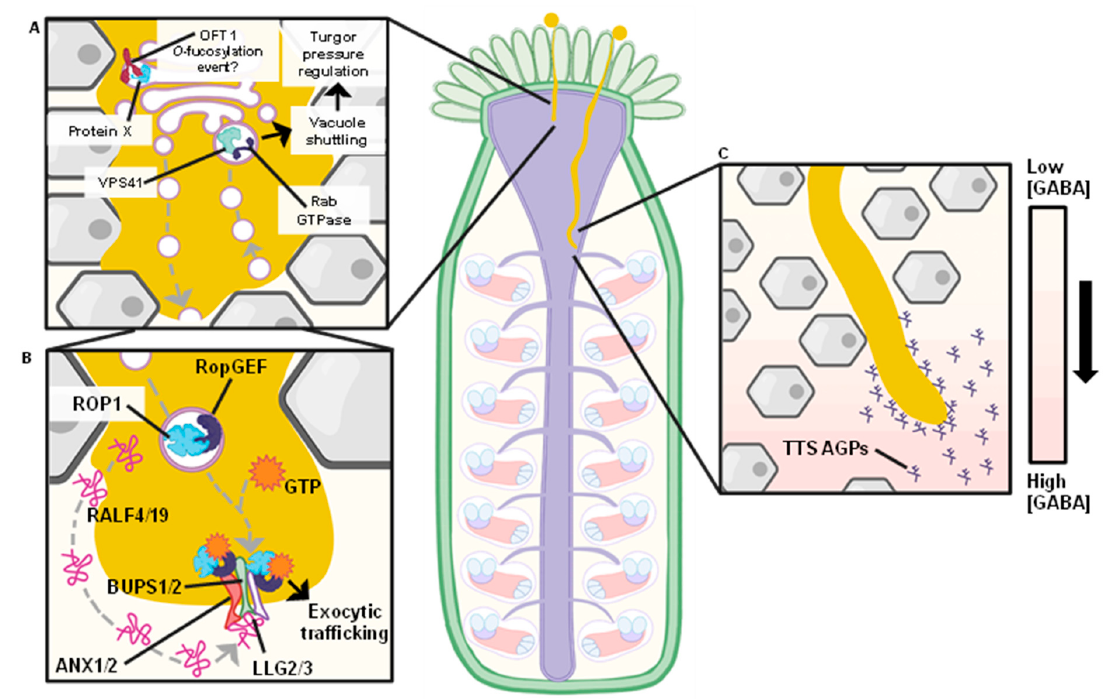
Figure 2. Schematic of physical barriers encountered by a germinating pollen tube at the style and transmitting tract. ( A ) Enlarged view of a germinating pollen tube navigating the tightly-packed style tissue. ( B ) The ANX1/2-BUPS1/2-LLG2/3 signaling complex is localized to the tip of the growing pollen tube and binds pollen tube-secreted RALF4/19, functioning as an autocrine signaling loop to prevent premature bursting. RopGEFs interact with the ANX1/2-BUPS1/2-LLG2/3 complex while activating ROP1, resulting in exocytic trafficking that may be essential for mechanotransduction signaling to occur for the pollen tube to exit the stigma-style interface ( C ) As the pollen tube penetrates further down the loosely packed transmitting tract, the pistil-produed γ -Amino-Butyric Acid (GABA) concentration gradient grows higher and Transmitting Tissue Specific (TTS) Arabinogalactan Proteins (AGPs) increase in abundance, both signaling to the pollen tube that it is navigating in the correct direction.